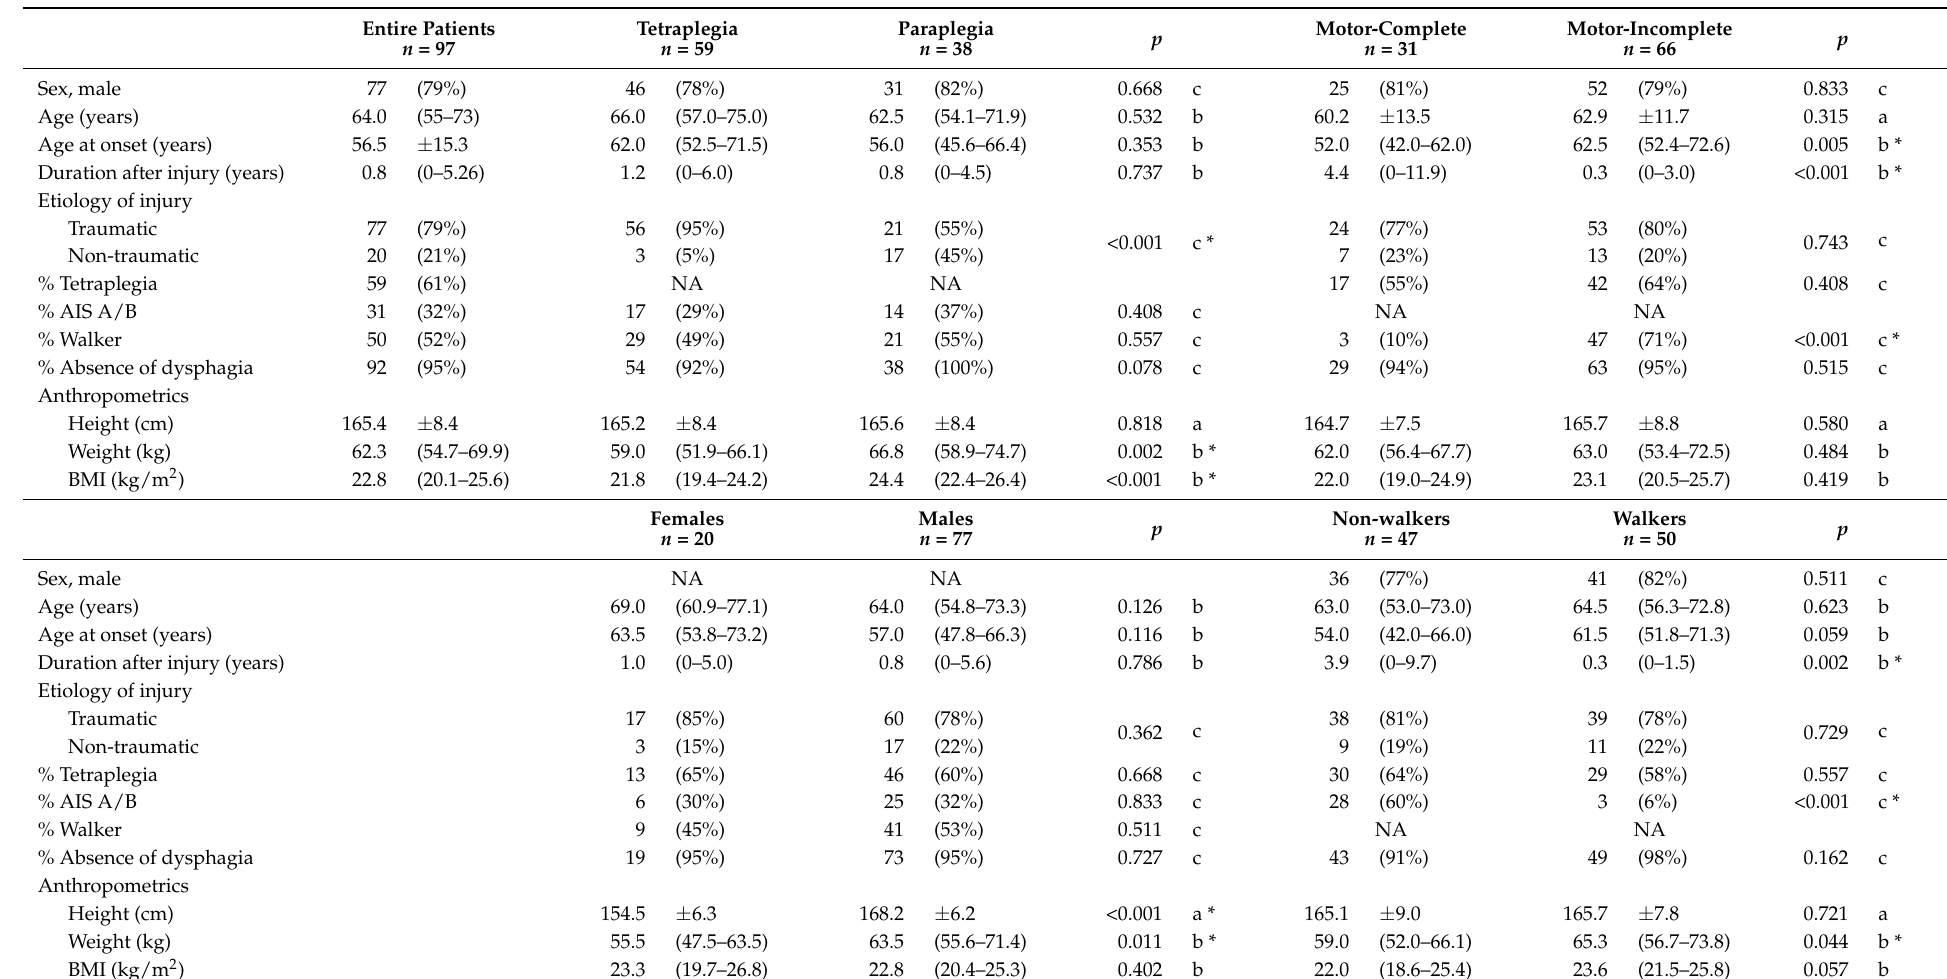
Table 2. Patients’